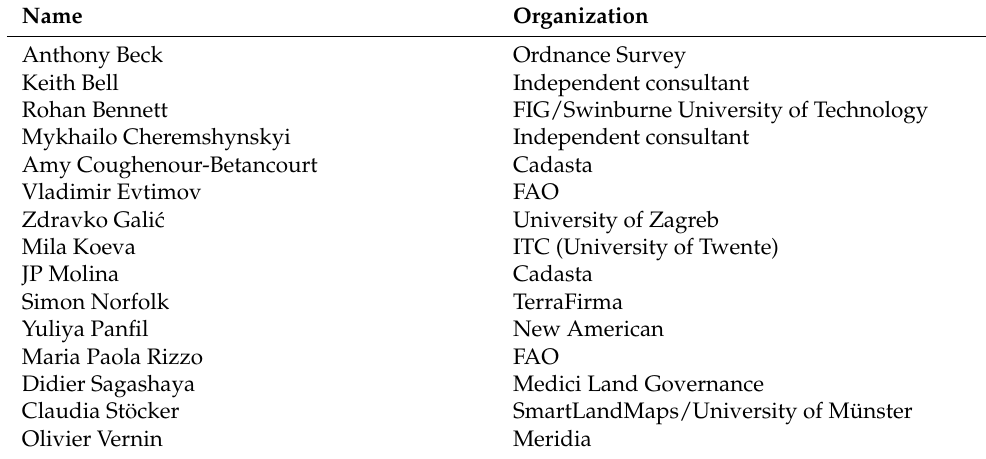
Table A2. List of